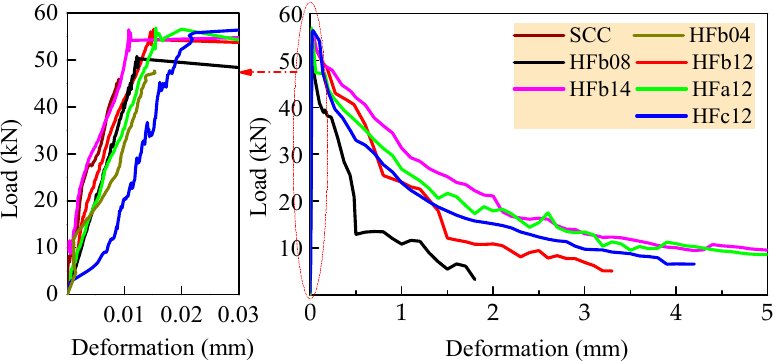
Figure 9 . The axial tensile load-deformation curves of self-compacting SFRC.